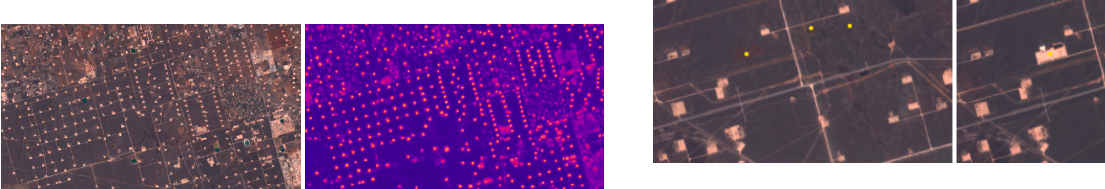
Figure C4. Example of an area where new development was found, before (left) and after (right) shown in Sentinel-2 imagery (ESA, 2020). Points in yellow indicate the locations of new well pad de-